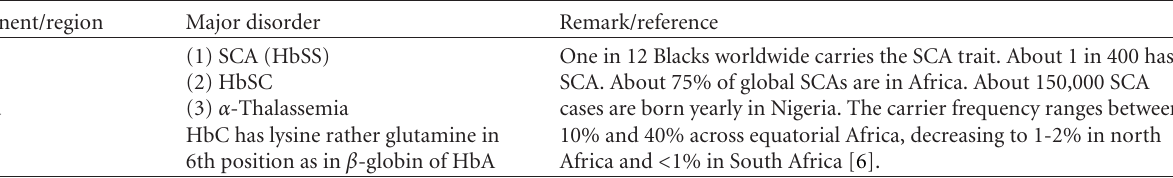
Table 1: Significant cases of SCDs including thalassemias by